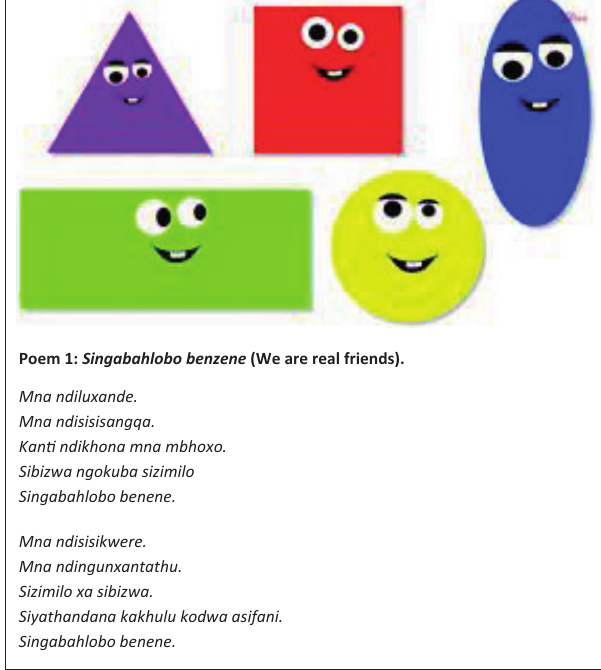
FIGURE 1: A Life Skills lesson shows shapes as true friends. As much as they are different from one another. The smiles indicates happiness and tolerance. Lastly, in a Mathematic lessons it is about shape awareness.